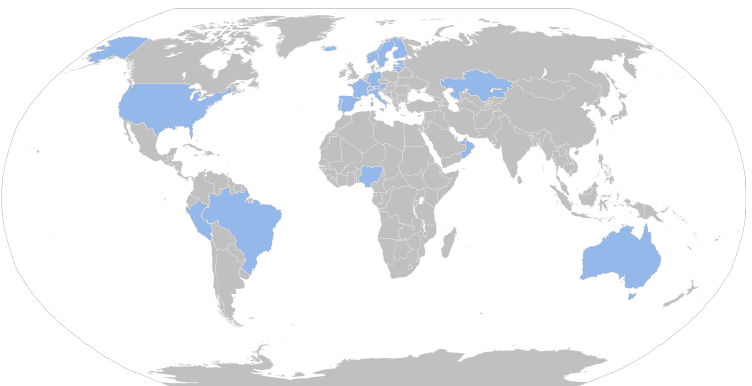
Figure 3. Overview of the selected countries for the eID